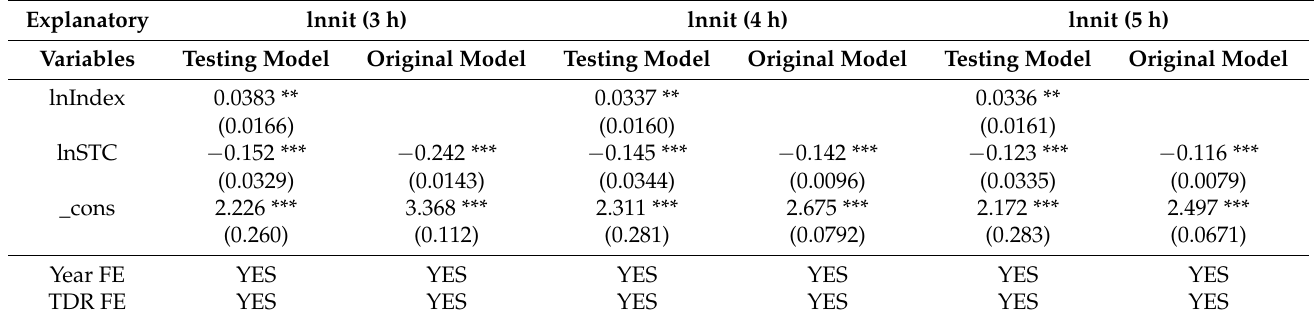
Table 7. Robustness